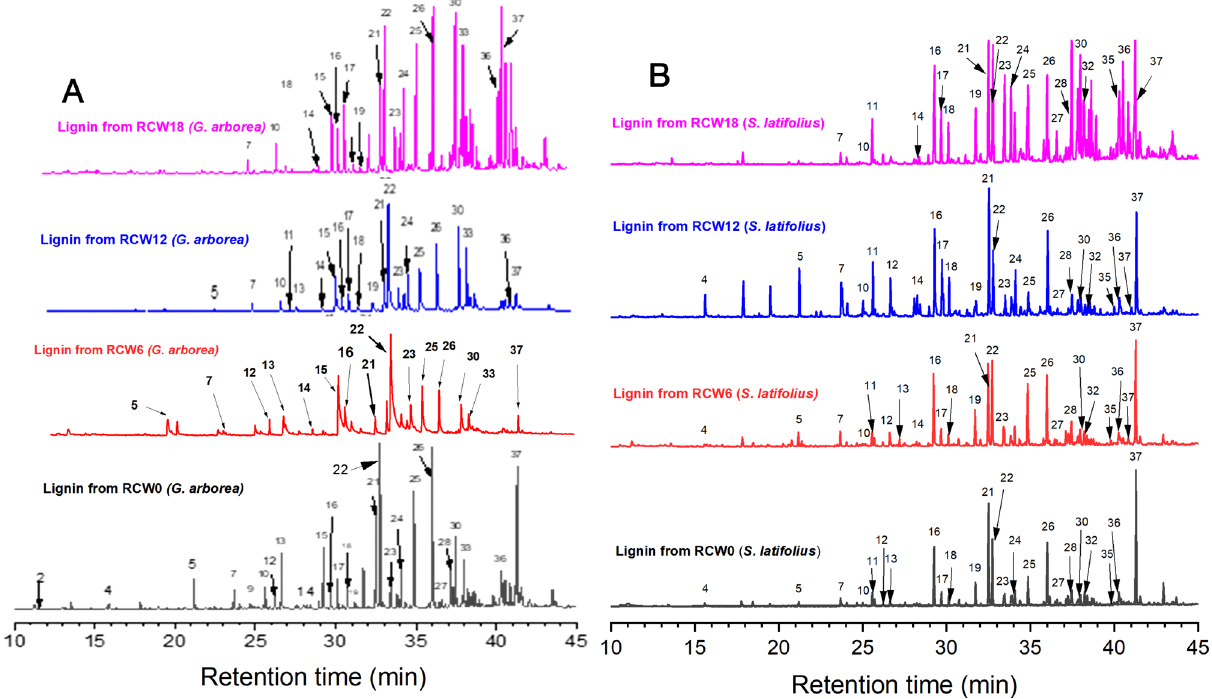
Figure 3. Pyrograms for RCW lignin from G. arborea ( A ) and S. latifolius ( B ). RCW 0: Initial RCW; RCW 6, RCW 12 and RCW 18 are RCW sampled after 0, 12 and 18 months in soils, respectively. Each peak number in this figure is followed by L to refer to